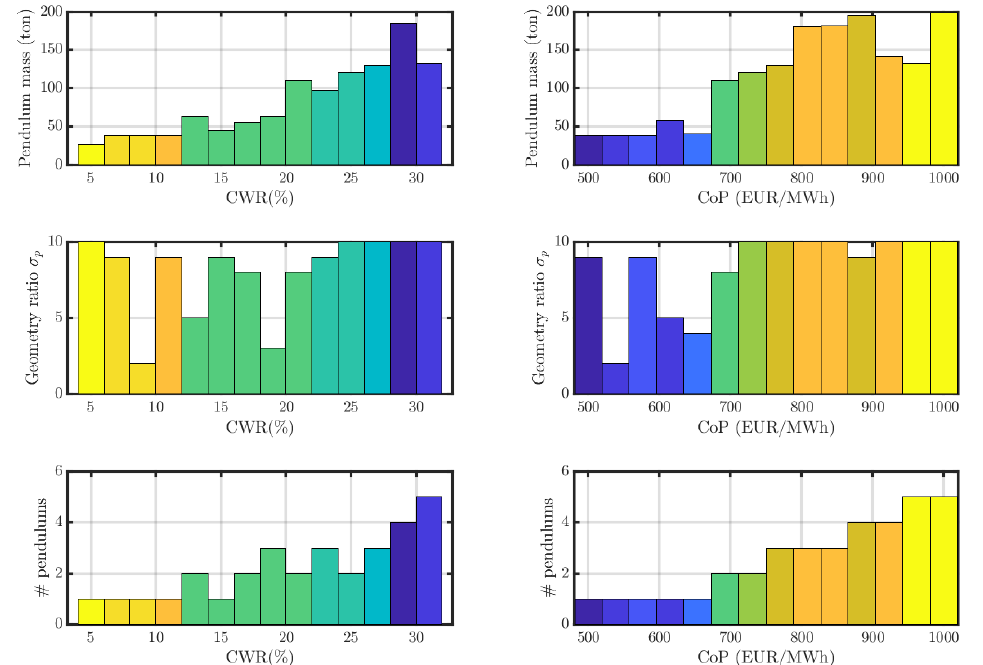
Figure 20. On the left: 14 individuals with the highest CWRs for each CWR-bin, with bars coloured proportionally to CWR. On the right: 14 individuals with the lowest CoPs for each CoP-bin, with bars coloured proportionally to